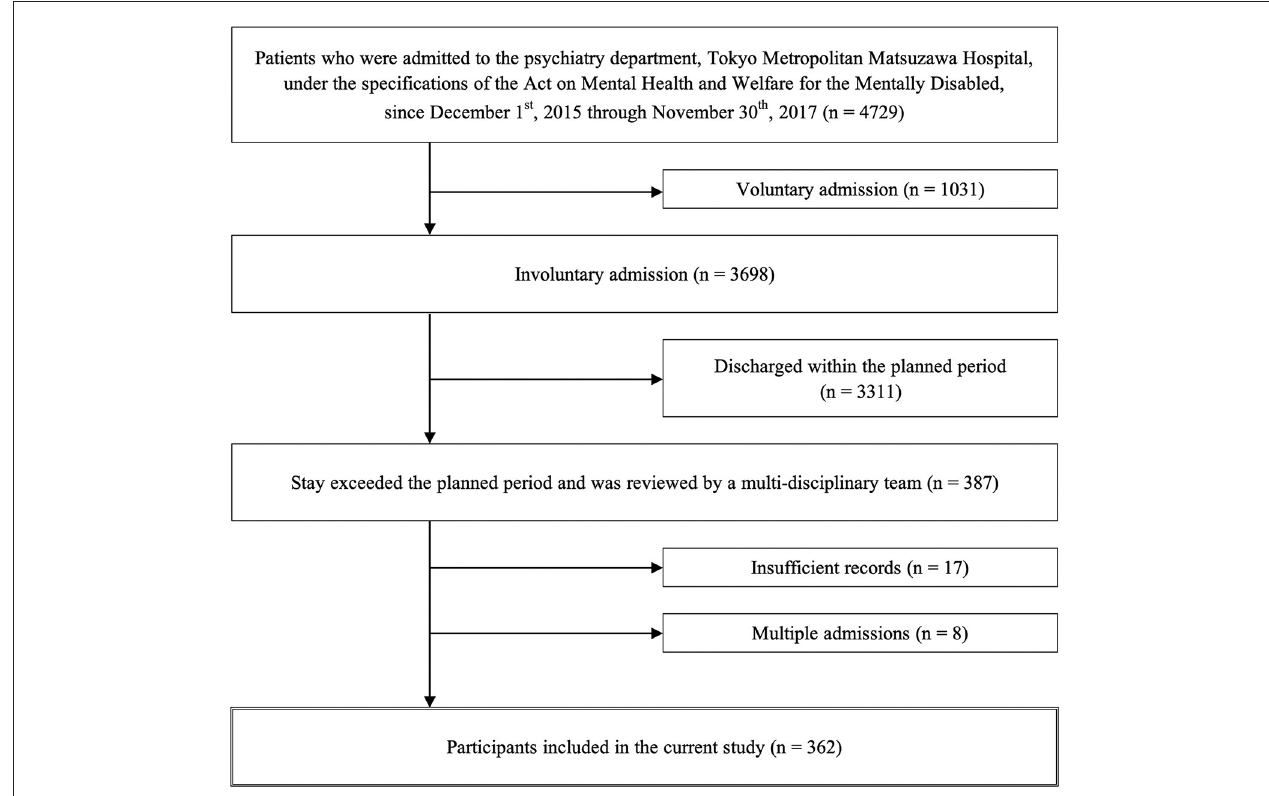
FIGURE 1 | Patient flowchart describing the inclusion and exclusion criteria to identify target cases for the study.